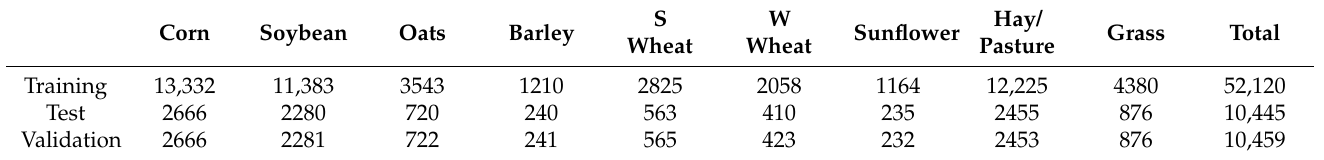
Table 1. The number of training, test, and validation samples in each class for the CEF dataset.